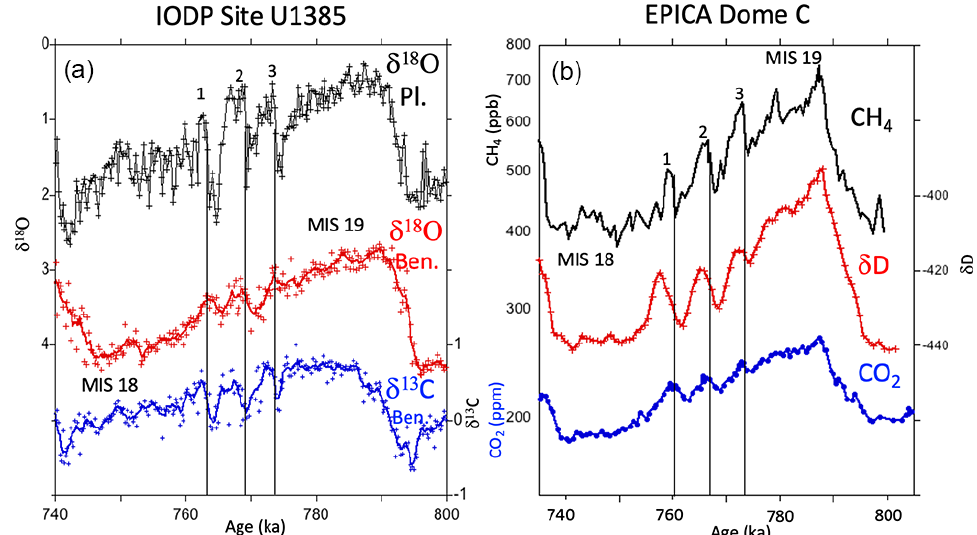
Figure 7. (a) Planktonic δ 18 O (black), benthic δ 18 O (red) and δ 13 C (blue) over the MIS19–18 transition at Site U1385 (Sánchez Goñi et al., 2016) compared to (b) CH 4 (black), δ D (red) and atmospheric CO 2 (blue) in the EPICA Dome C ice core. Three strong millennial events (labelled 1–3) occur on the MIS19–18 transition that are recorded in both the marine sediment and ice cores. Vertical dashed lines are drawn at the abrupt transitions from cold stadials to warmer interstadial conditions. Note that the phasing of ice core CH 4 and δ D is not quite as expected from later time periods (Fig. 6) and may reflect uncertainty in (cid:49) age (the age difference between the ice and gas records).